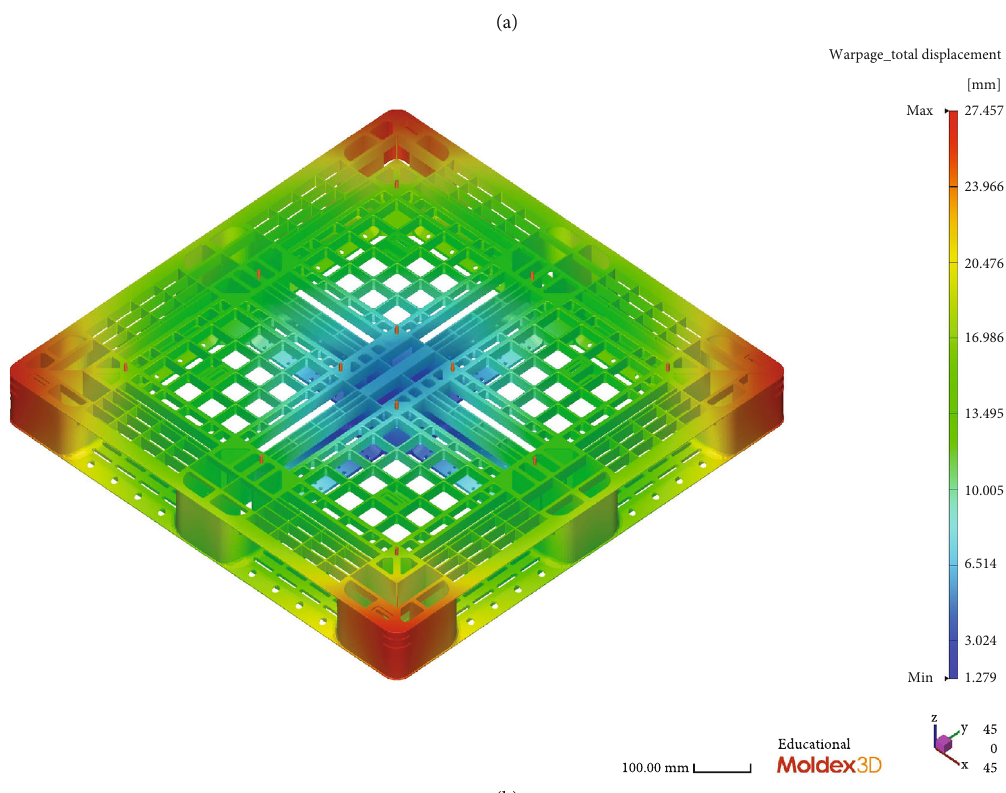
Figure 11: Warpage total deformation. (a) Concurrent valve gate opening scheme (0.799 ~ 27.926mm). (b) Sequential valve gate opening scheme (1.279 ~